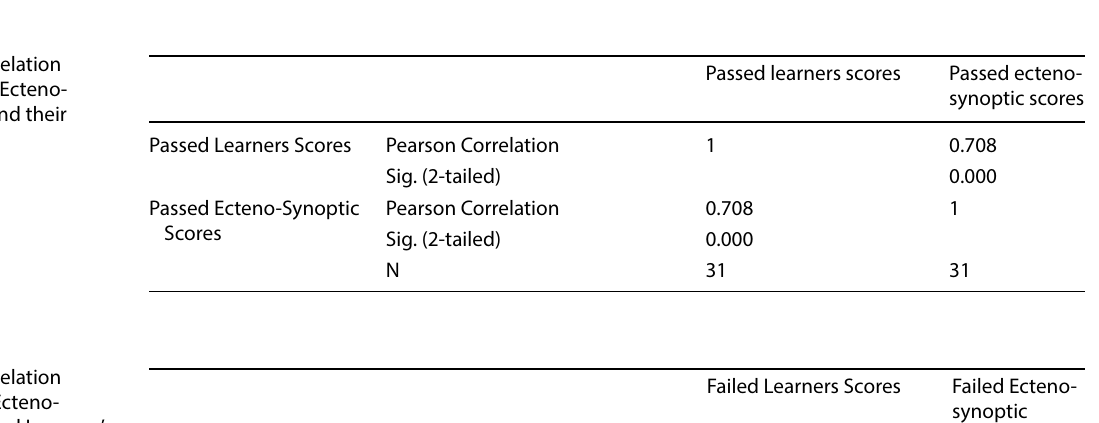
Table 4 The Correlation between Failed Ecteno- Synoptic Score and Learners’ Reading